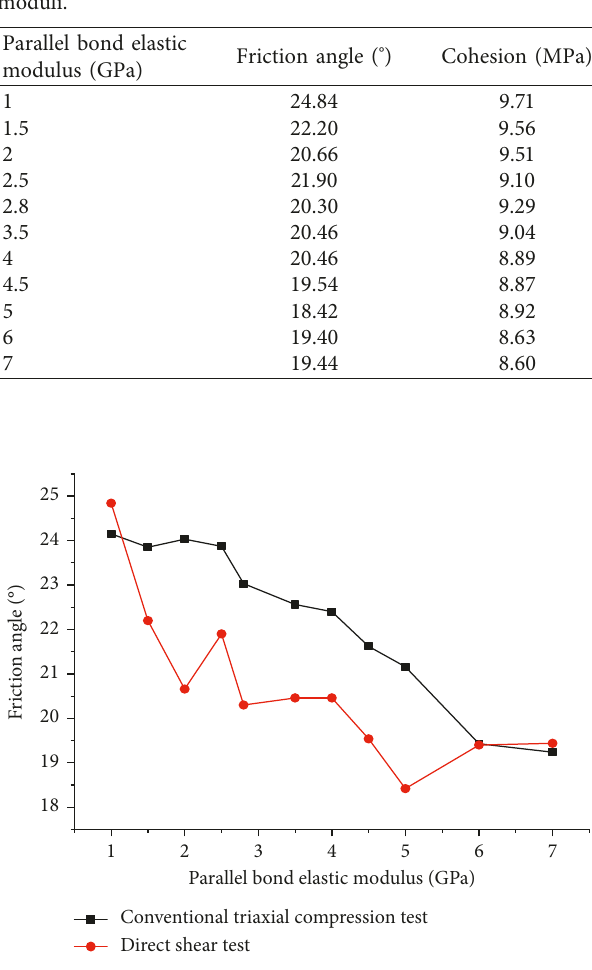
Figure 7: Theeffectof parallel bondelastic moduluson friction angle.